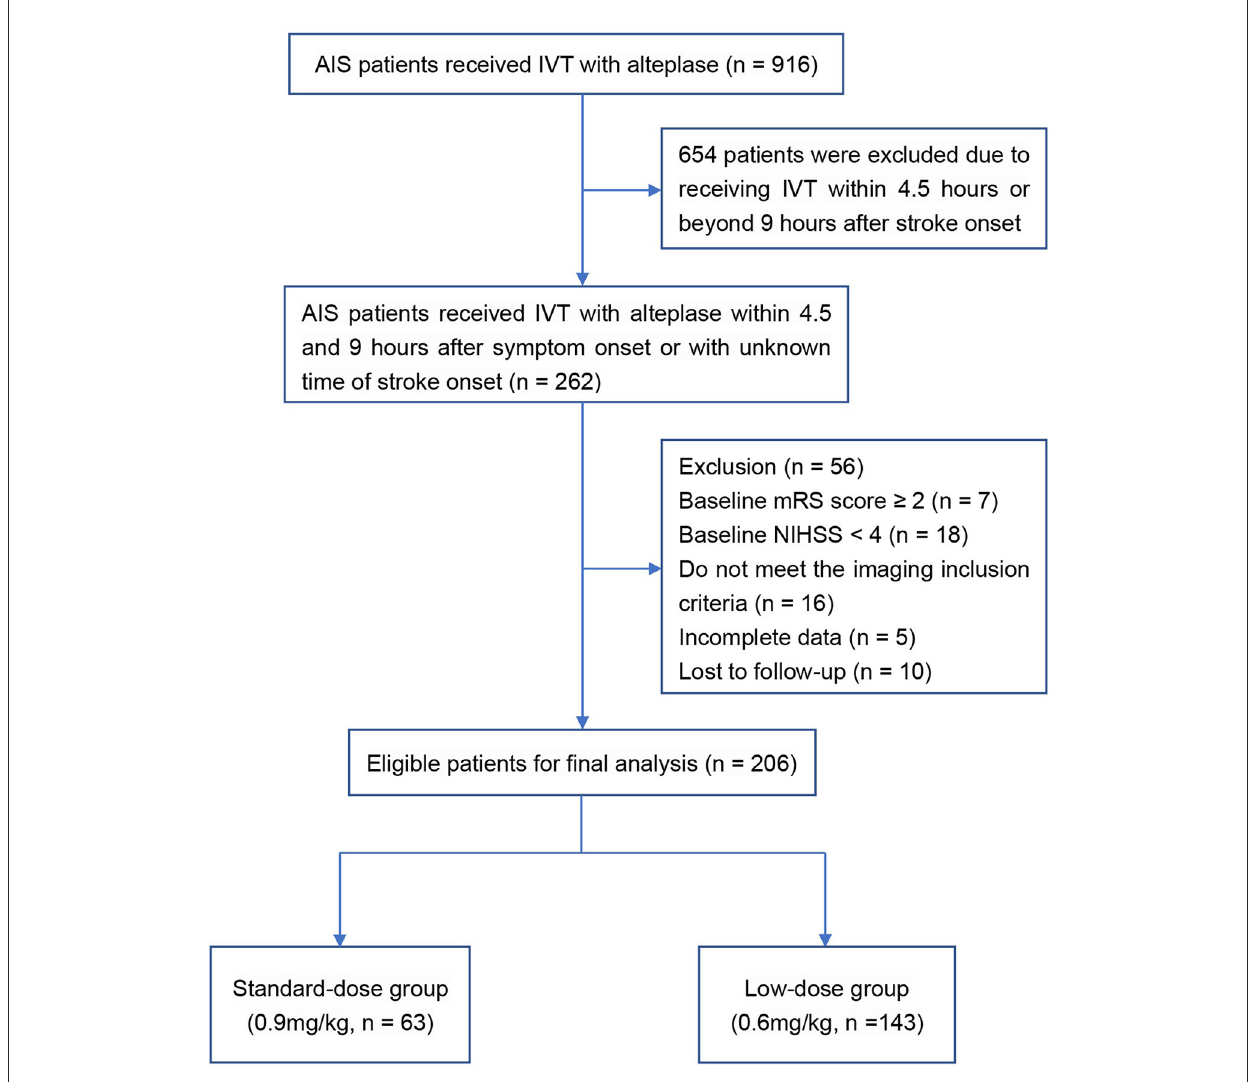
FIGURE1 Flowchart of patient